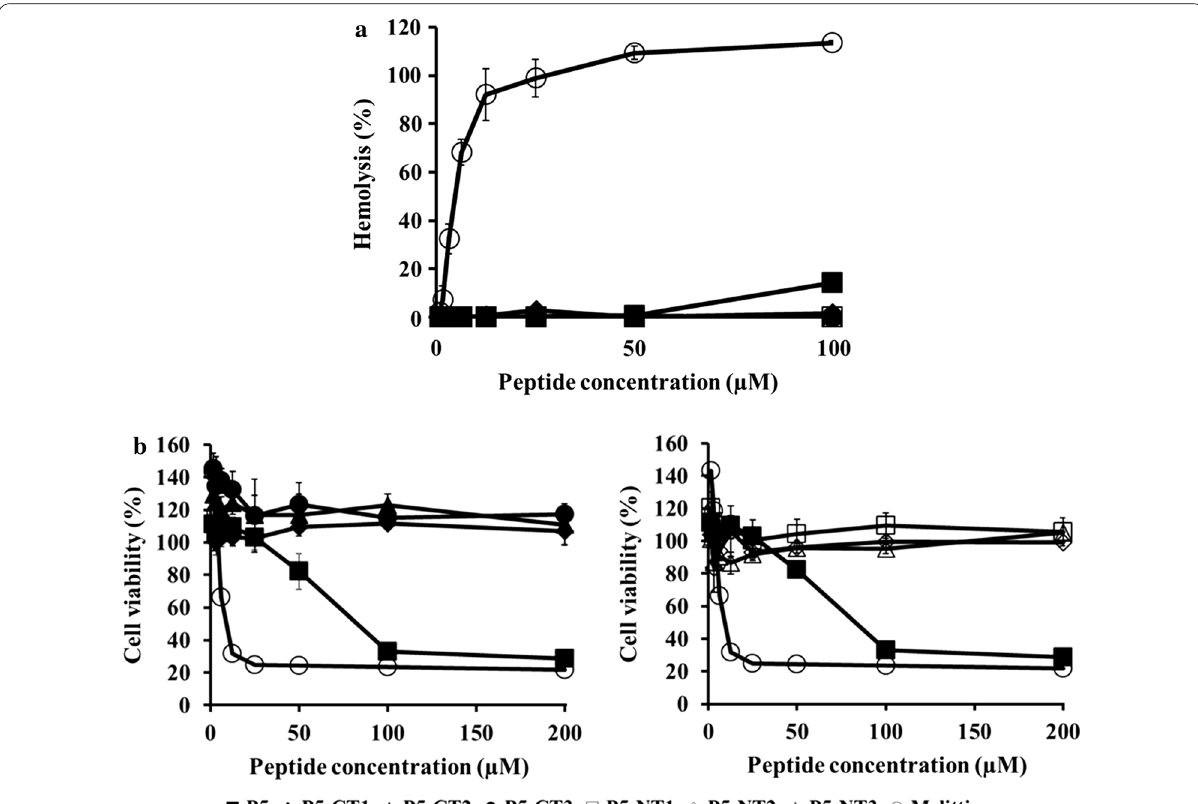
Fig. 4 Hemolytic activity of peptides against mouse red blood cells and cytotoxicity of the peptides against HaCaT cells. a Hemolytic activity of peptides concentrations from 0 to 100 µM. b Cytotoxicity of peptides concentrations from 0 to 200 µM. Each experiment was repeated three times. CT C-terminus, NT